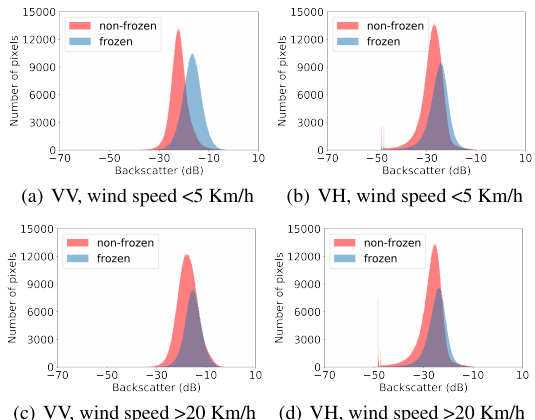
Figure 4: Distribution of frozen and non-frozen pixels for VV and VH polarisations in different wind speed conditions (com- bined data from 3 lakes, 2 winters). Best if viewed on screen.